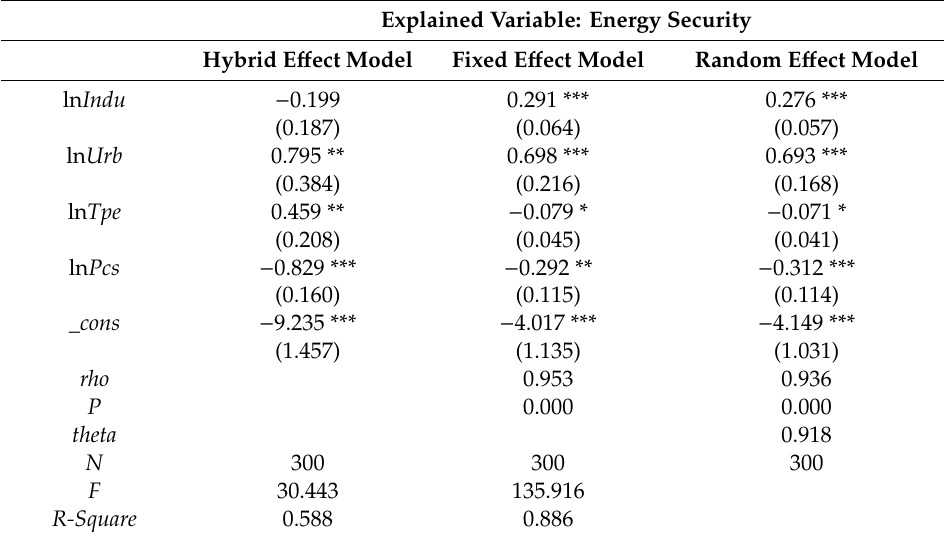
Table 2. Comparison of estimation results of three regression